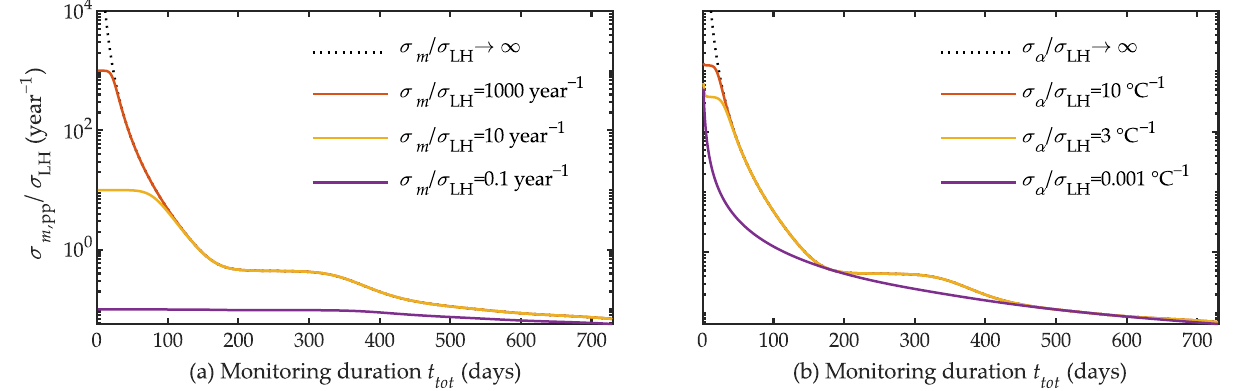
Figure 4. Impact of the prior distributions of parameters α and m on the pre-posterior uncertainty. The graphs are plotted against the monitoring duration t tot from 1 to 730 days, b = 0, f s = 1. ( a ) σ m / σ LH → ∞, σ α / σ LH varies from 10 to 0.001 °C −1 ; ( b ) σ α /σ LH → ∞, σ m / σ LH varies from 1000 to 0.1 year −1 . When the prior distribution of the model parameters is highly uncertain (orange solid lines), Equation (12) provides the same results as Equation (14) (black dashed lines), apart from very short monitoring durations.